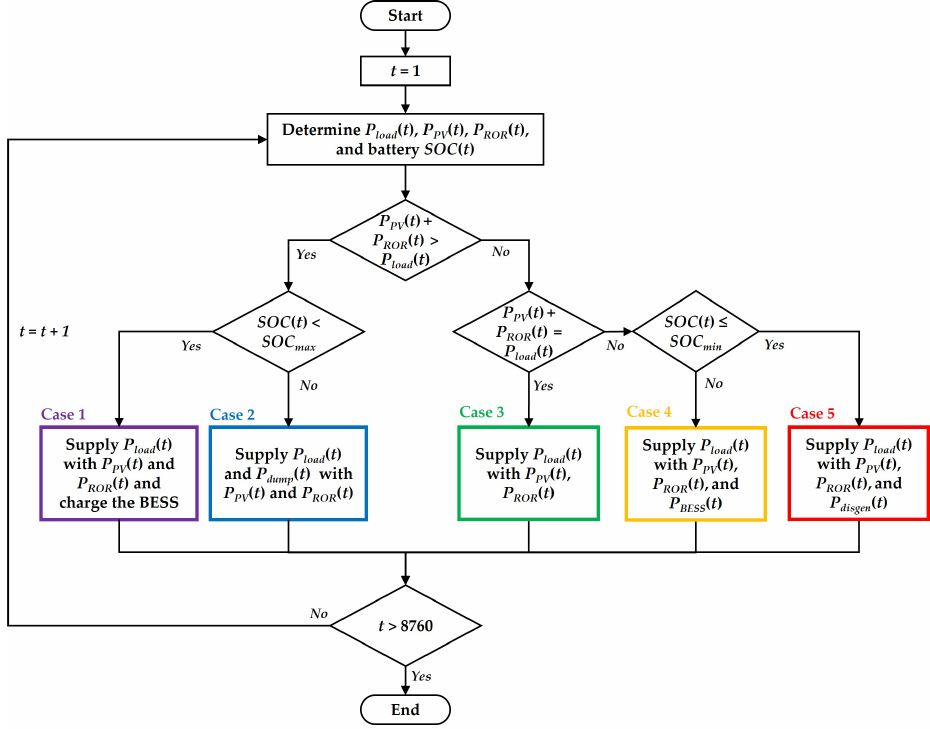
Figure 7. Primary flowchart of the HREM operation with power management strategy.